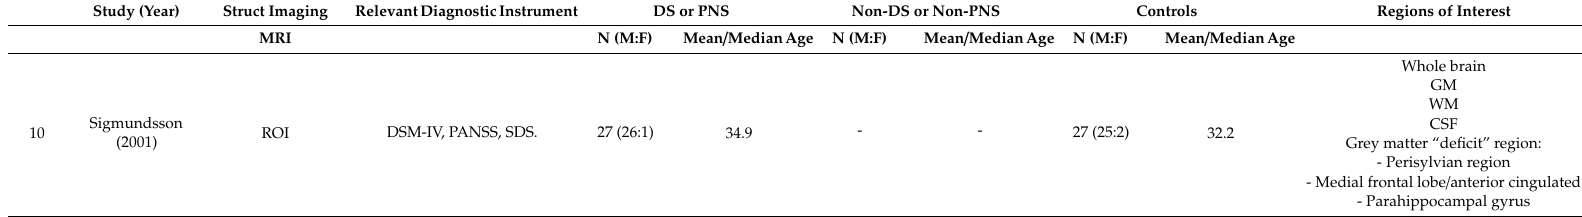
Grey matter “deficit” region: - Perisylvian region - Medial frontal lobe / anterior cingulated - Parahippocampal gyrus 24 ROIs for NDS vs. HC only. Superior Medial Prefrontal Grey Superior Central Prefrontal Grey Superior Lateral Prefrontal Grey Inferior Medial Prefrontal Grey Inferior Central Prefrontal Grey Inferior Lateral Prefrontal Grey Hemispheric Prefrontal Grey Total Prefrontal Grey Superior Medial Prefrontal White Superior Central Prefrontal White Superior Lateral Prefrontal White 35.8 Inferior Medial Prefrontal White Inferior Central Prefrontal White Inferior Lateral Prefrontal White Hemispheric Prefrontal White Total Prefrontal White Hippocampus Parahippocampus Superior Temporal Gyrus Hemispheric Whole Temporal GM Total Whole Temporal GM Hemispheric Whole Temporal WM Total Whole Temporal WM Regional Volumetric Measurements: Left Temporal Right Temporal 28 Left Frontal Right Frontal Local gyrification index of: Right, Left dorsal medial prefrontal cortex, Right, Left ventromedial prefrontal cortex, Right, Left anterior cingulate gyrus, Right, Left superior frontal cortex, Right, Left medial orbitofrontal gyrus, 25.8 Right, Left lateral orbitofrontal gyrus, Right, Left rostral anterior cingulate gyrus, Left postcentral gyrus, Left lingual gyrus, Right posterior cingulate gyrus, Right inferior parietal lobule Right lateral occipital